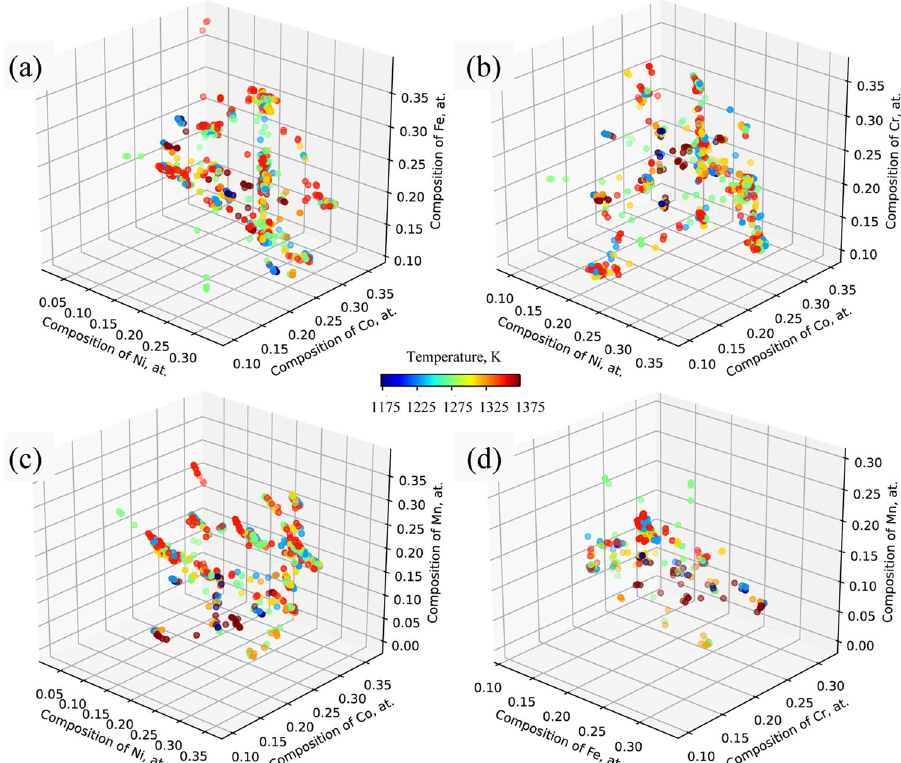
Fig. 2 Composition and temperature space of the dataset. Distributions of the composition points are viewed from composition coordinates of different components, i.e., a Ni, Co and Fe, b Ni, Co and Cr, c Ni, Co and Mn, and d Fe, Cr and Mn, among concerned temperature range for the dataset of fcc CoCrFeMnNi